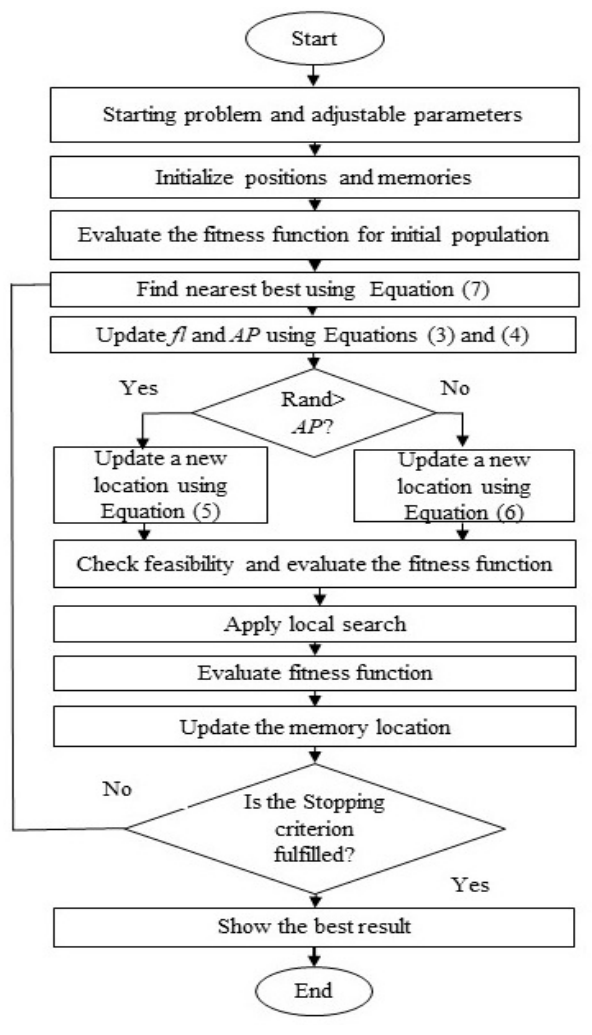
Figure 4. Niching Crow Search Algorithm’s flow chart. Algorithm 1 Pseudo Code: Proposed NCSA